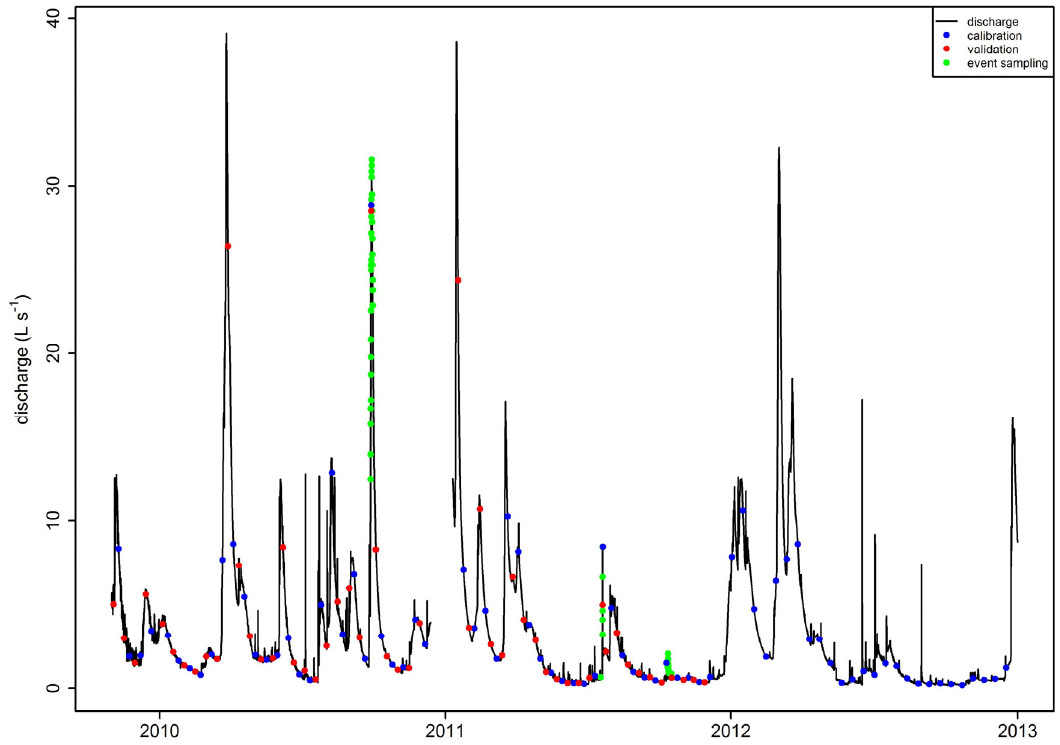
Figure 1. Time series of measured discharge with sampling points; blue dots: data used to establish the respective load calculation equations; red dots: data used only for validation; green dots: sampling during storm events.